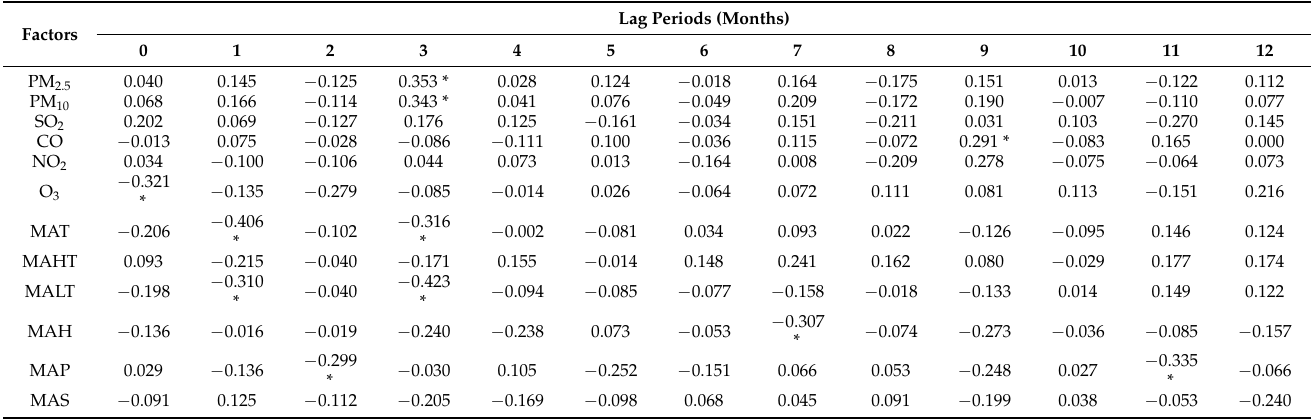
Table 3. CCF coefficients between the prewhitened ambient factors residuals series with different time lags and the prewhitened PTB incidence residuals series from 2015 to 2018.